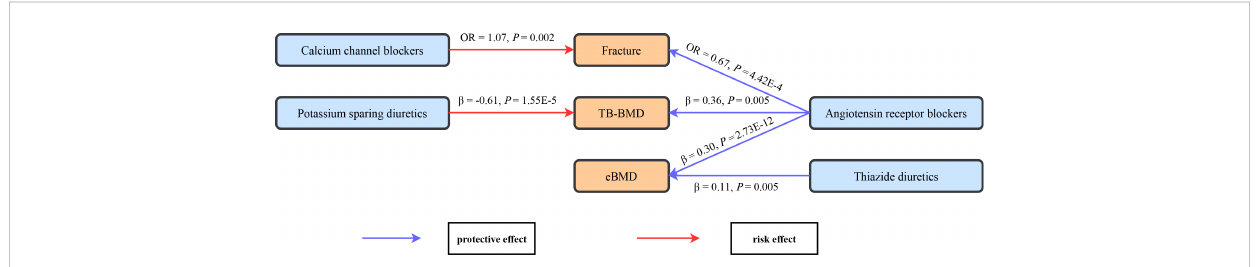
FIGURE 4 The schematic for the signi fi cant causal effects of antihypertensive drugs on bone health-related traits. Signi fi cant causal effects are presented as arrows with the estimated effect sizes alongside, with the red arrow representing risk effect and the blue arrow representing protective effects. TB- BMD, total body bone mineral density; eBMD, estimated heel bone mineral